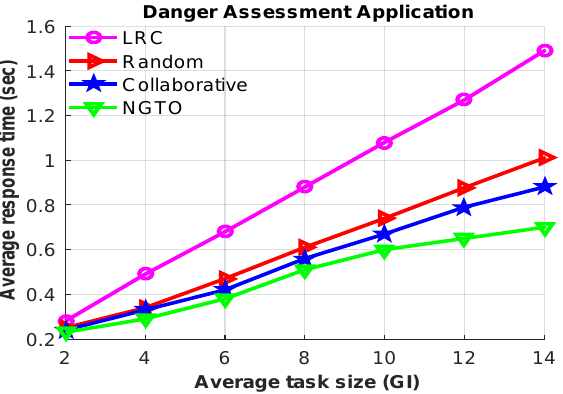
Figure 9. The average response times for different task sizes of danger assessment